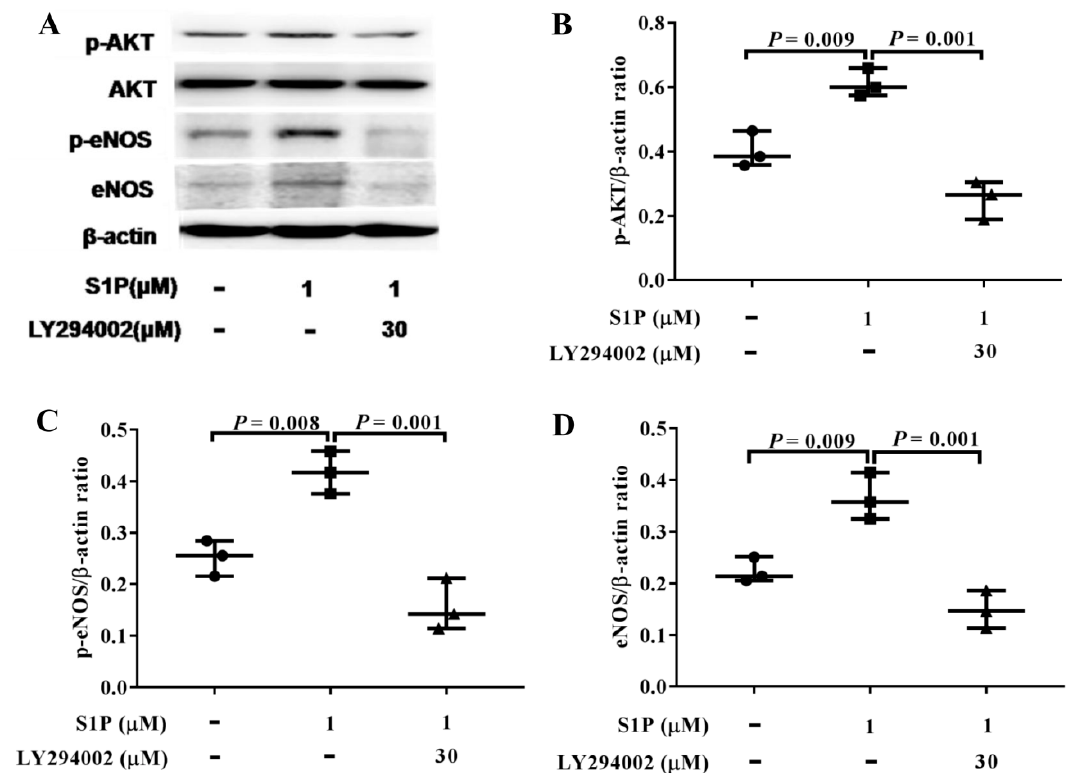
Figure 5. LY294002 inhibits S1P-induced activation of p-AKT, p-eNOS, and eNOS in EPCs. Western blot analyses of p-AKT, p-eNOS, and eNOS in EPCs treated with S1P at 1 µ M or S1P at 1 µ M plus LY294002 at 30 µ M ( A – D ) were performed.